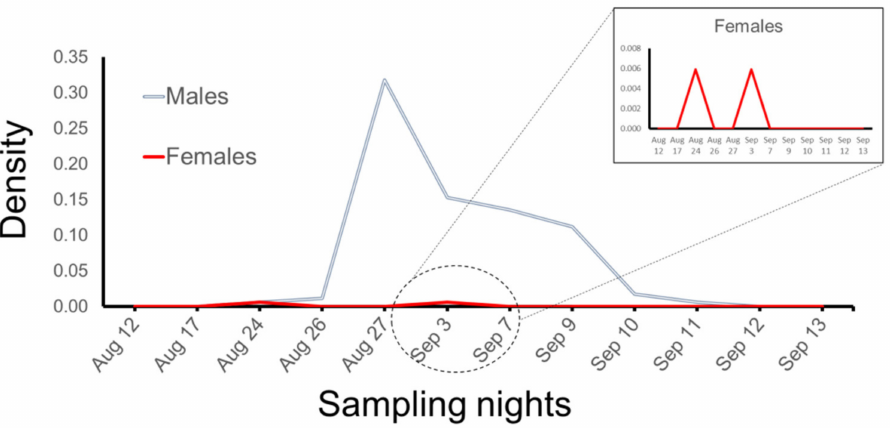
Figure 2. Minimum observed density per survey night of Vesperus luridus at the study area in Oriolo Romano, central